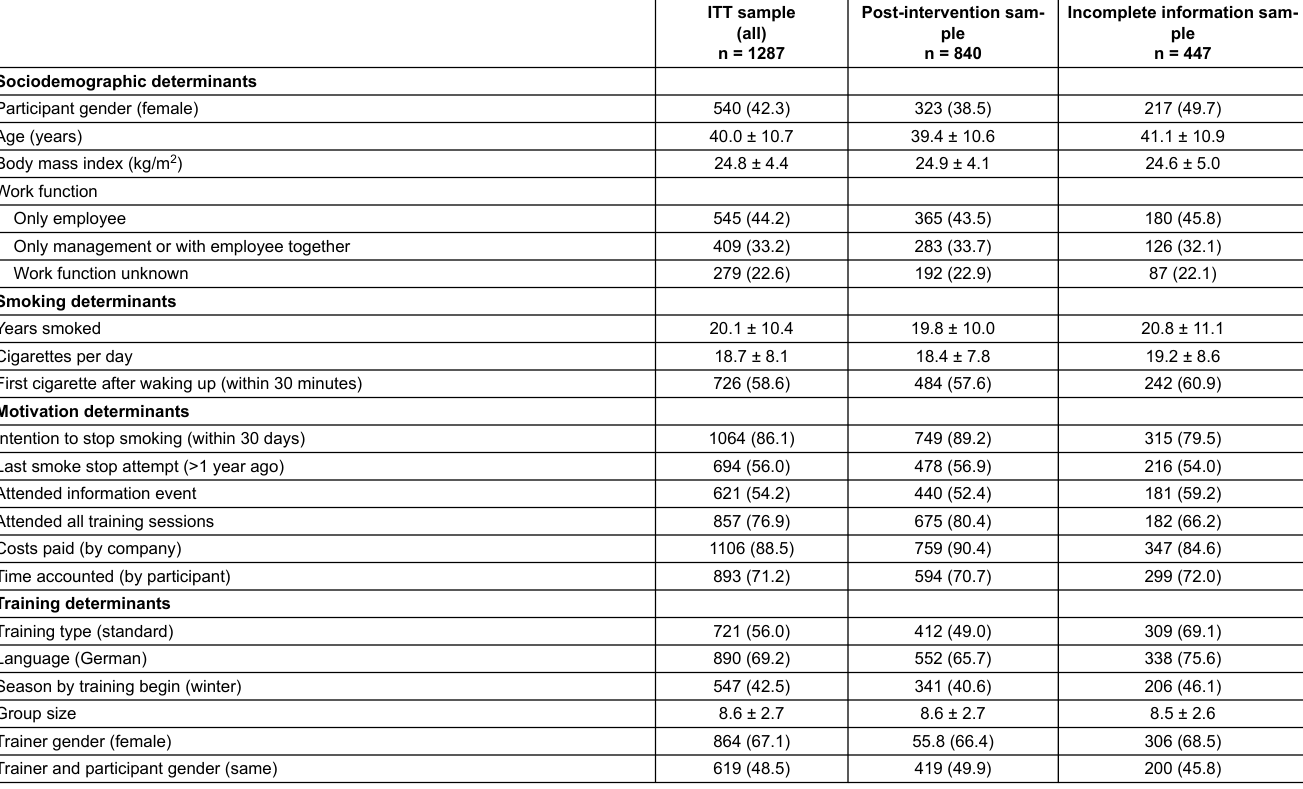
Table 2: Baseline characteristics of participants and training in Enterprise Smoke-free, stratified by subsample of participants.